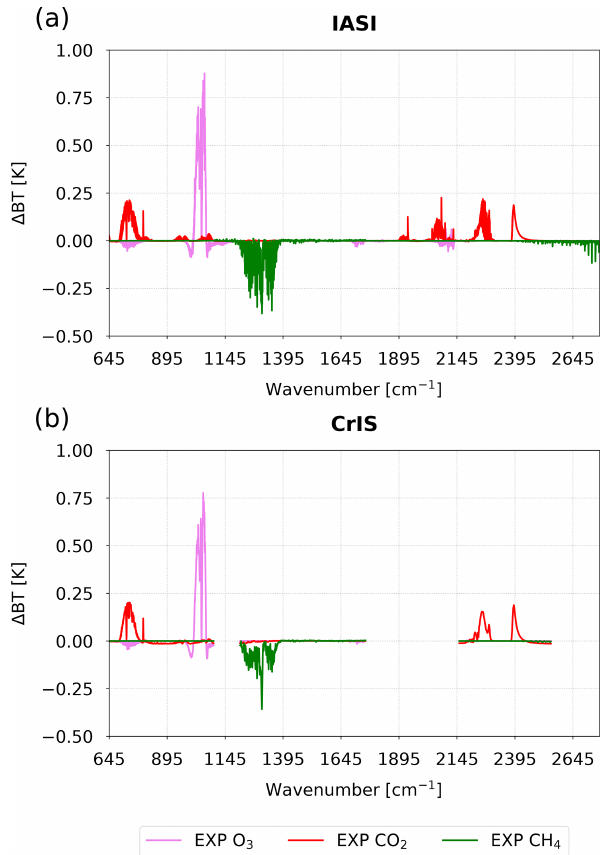
Figure 10. Difference between real and simulated observations (O–B) using chemical information from reference profiles (black line) and from in situ profiles (red line) with respect to IASI- monitored (a) and CrIS-monitored (b) channels for in situ sounding from 17 April 2018 at